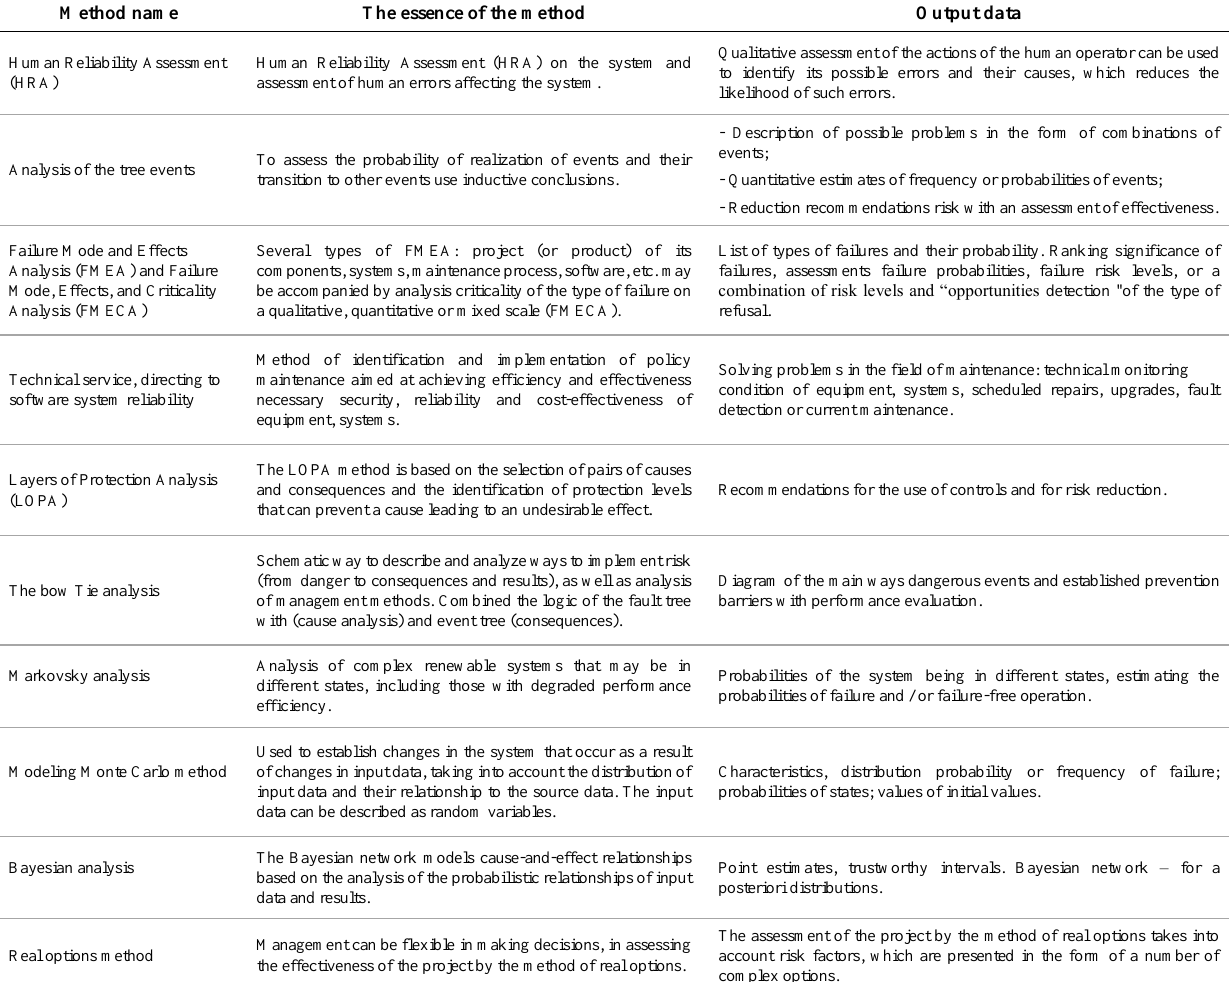
Table 2. Quantitative methods of risk